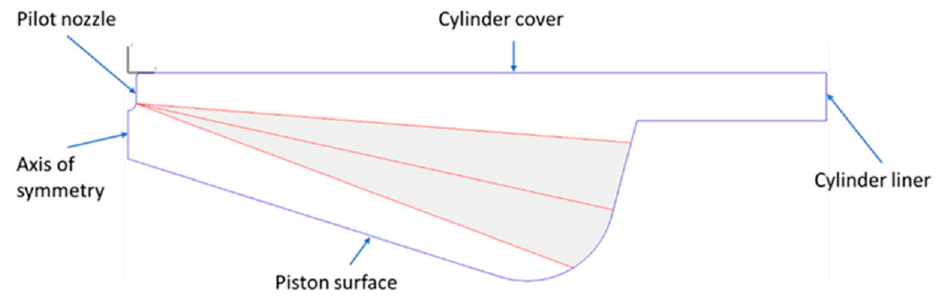
Figure 3. Half of the symmetry combustion chamber geometry.